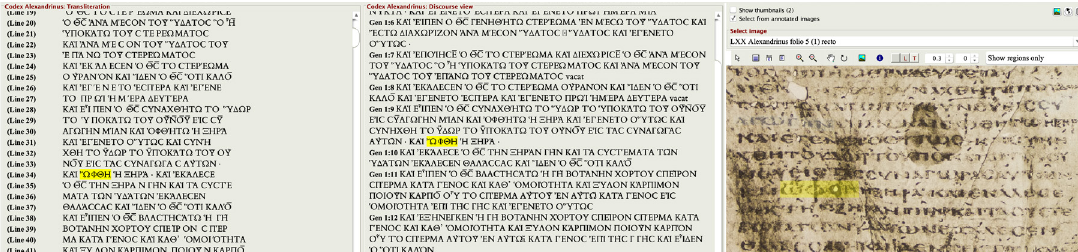
Figure 20: Codex Alexandrinus with a second hot-spot; image of Facsimile of Codex Alexandrinus (London: British